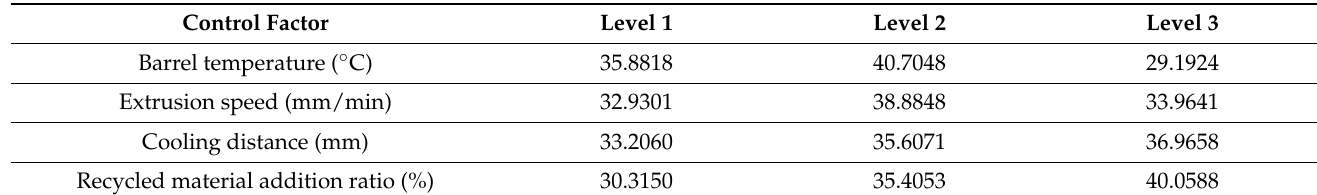
Table 3. Response table of S/N ratio based on the-larger-the-better quality characteristics.